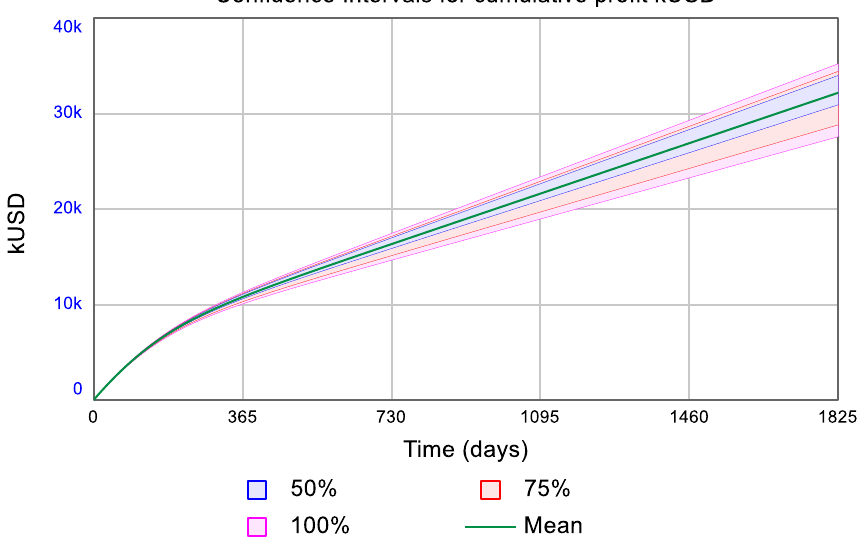
Figure 13. Cumulative profit over five years (1825 days) for di ff erent values of the number of borehole units per repair, replacement, and maintenance crew. The mean value and confidence intervals are